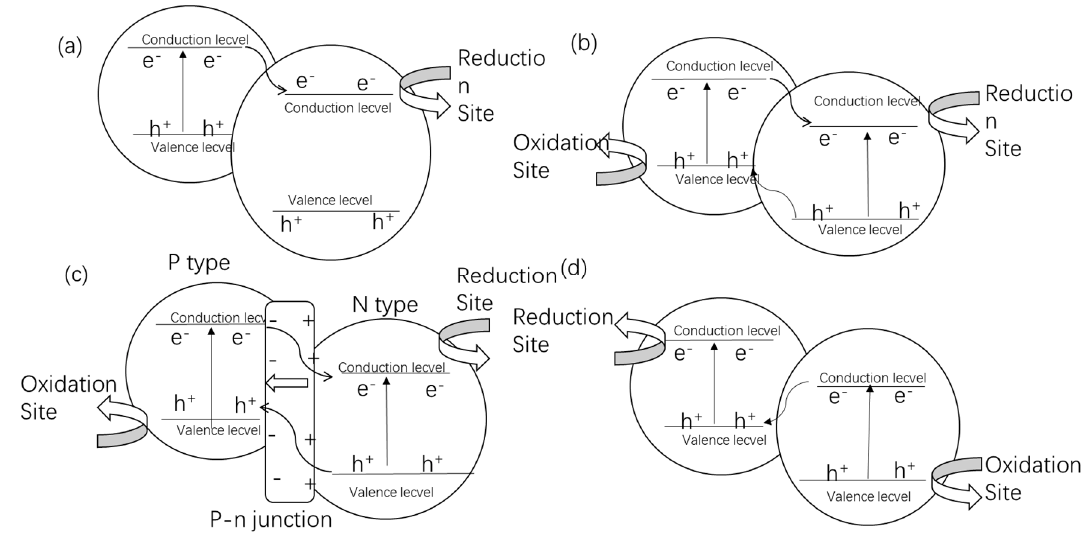
Figure 4. Charge-carrier transfer process in sensitization ( a ), traditional ( b ), p-n junction ( c ), and vectorial Z-scheme ( d )